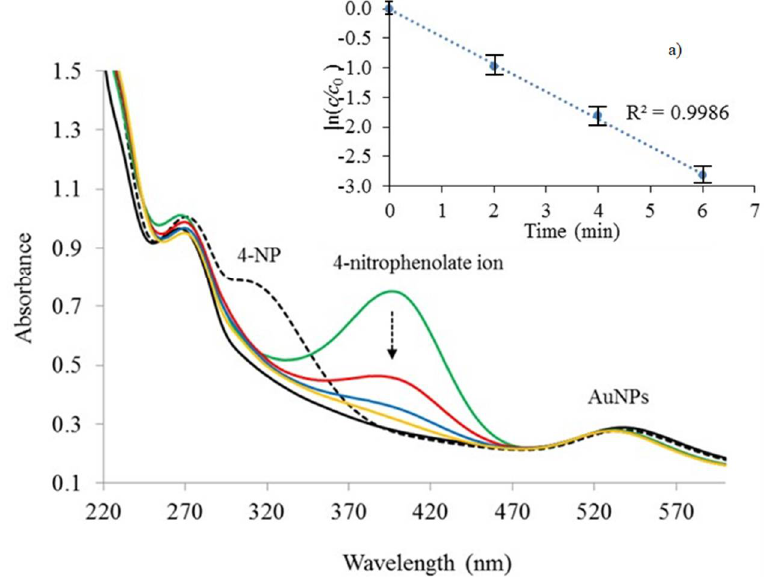
Figure 6. UV–vis spectra over the course of the reduction of 4-nitrophenol (4-NP) by AuNPs 1% tea. Reaction conditions: [AuNPs] = 3.2 × 10 − 5 M; [4-NP] = 3.8 × 10 − 5 M; [NaBH 4 ] = 1.6 × 10 − 3 M. Starting AuNPs tea extract aqueous solution (dark solid line); upon addition of 4-NP (dark dashed line); formation of 4-nitrophenolate (green solid line). Reduction reaction after 2 min (red solid line), after 4 min (blue solid line), and after 6 min (yellow solid line). Inset: a) ln( c / c 0 ) versus time ( c = [4-nitrophenolate]).